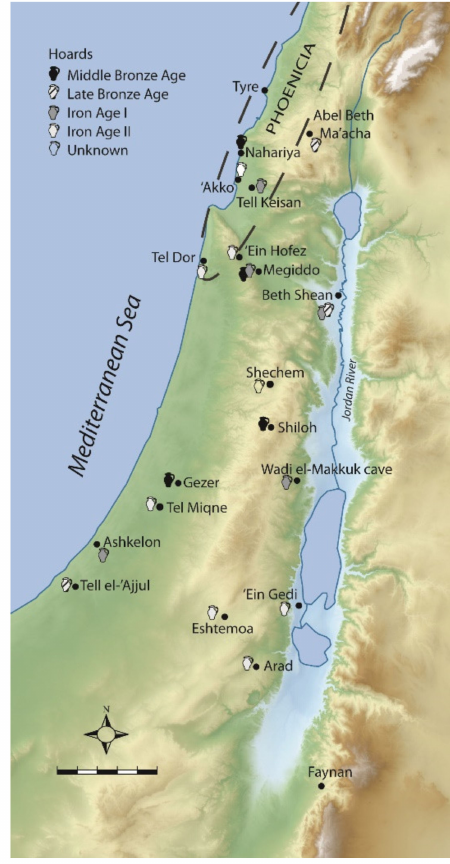
Figure 1. Map of the Southern Levant showing sites with Bronze and Iron Age silver hoards. (Drawing by S. Matskevich; Reproduced after